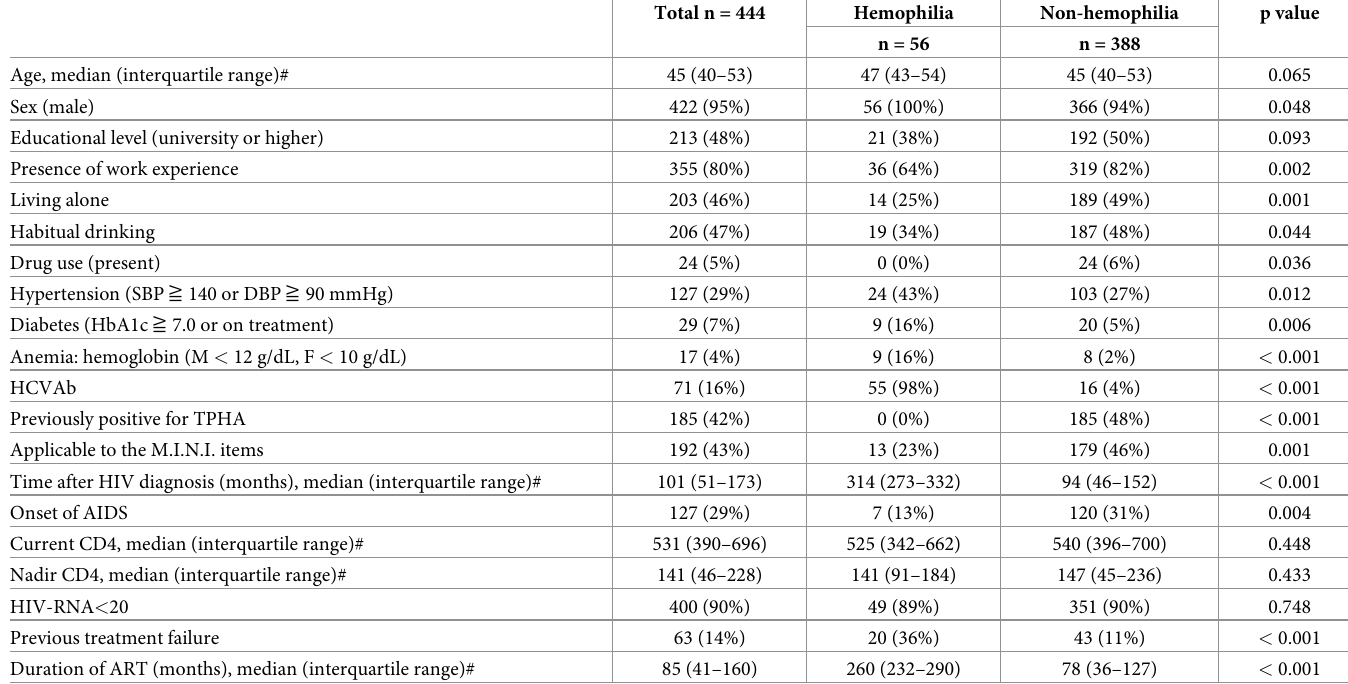
Table 1. Patient